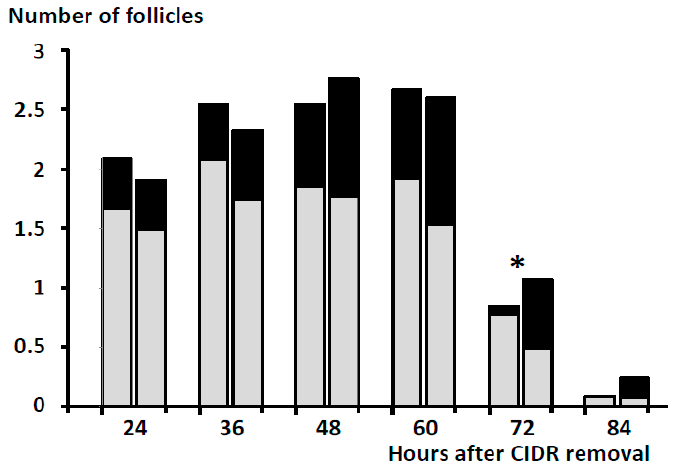
Figure 1. Mean number of follicles with a diameter of 3–4 mm (grey bars) or ≥ 5 mm (black bars) in sheep treated with Controlled Internal Drug Release (CIDR) devices for five days and 400 IU of eCG at CIDR removal + 5 mg of prostaglandin F2 α (Group eCG; left bars at each time-point) or 500 IU of hCG at 24 h after CIDR removal (Group hCG; right bars at each time-point). Asterisk denotes significant difference ( p <